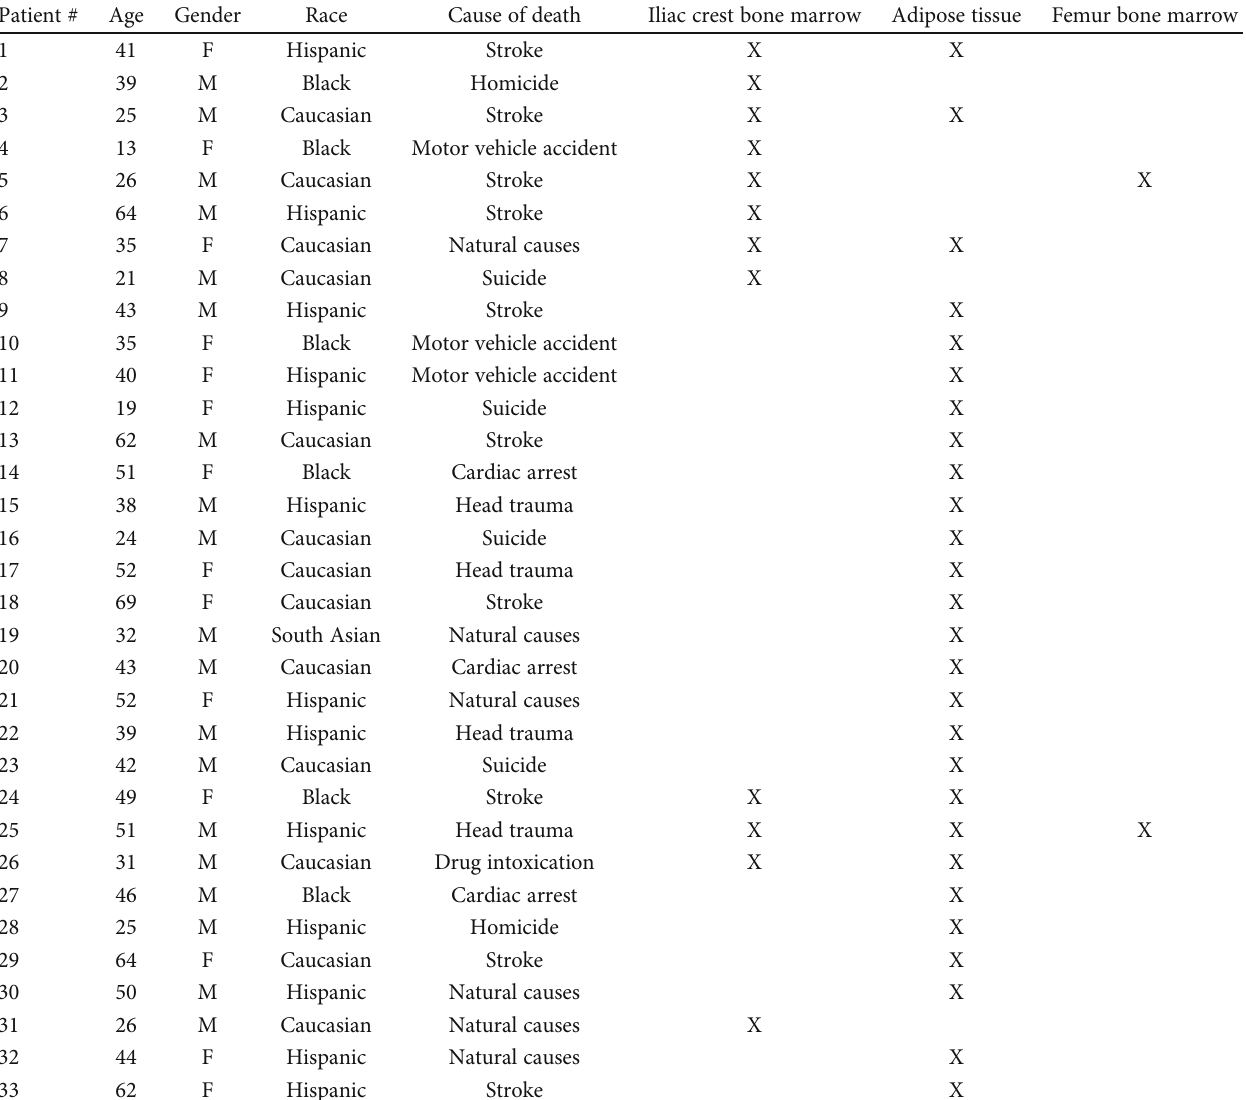
Table 1: Patient